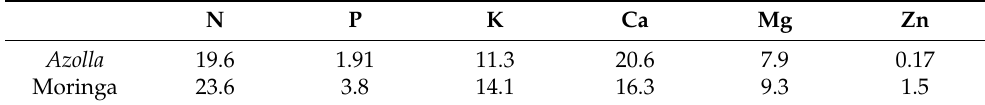
Table 2. Azolla and moringa chemical constituents (mg g − 1